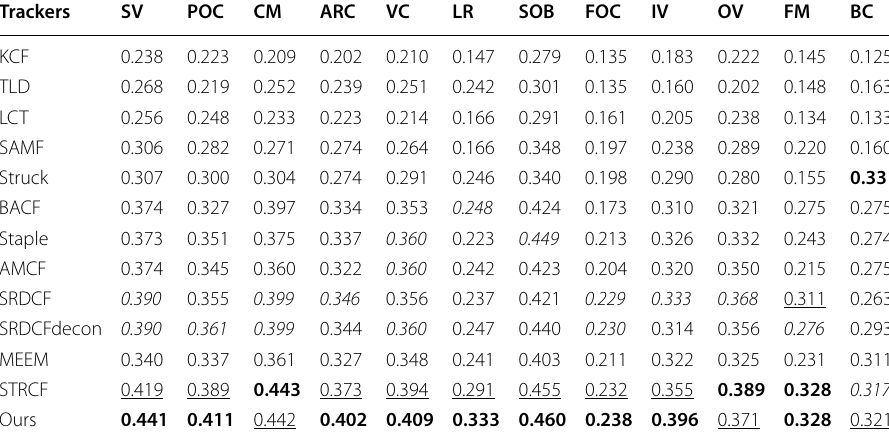
The top three ranking trackers in each attribute are marked in bold, underlined, and italic fonts, respectively